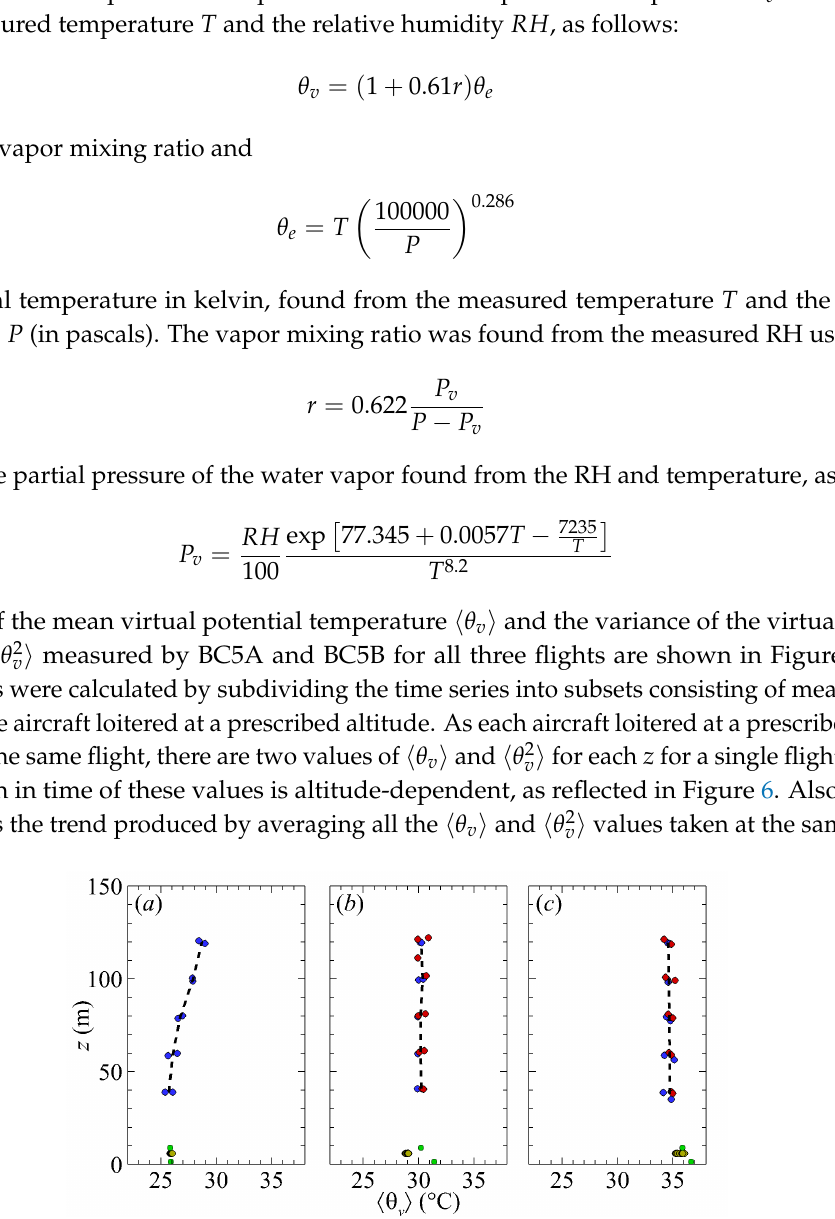
Figure 7. Vertical profiles of mean virtual potential temperature measured during ( a ) flight 1, ( b ) flight 2, and ( c ) flight 3. The blue symbols indicate measurements made by BC5A, the red symbols indicate measurements made by BC5B, the olive symbols indicate measurements made by the sonic anemometer, and the green symbols indicate measurements made by the Mesonet tower. The dashed line indicates the trend produced by averaging measurements at each